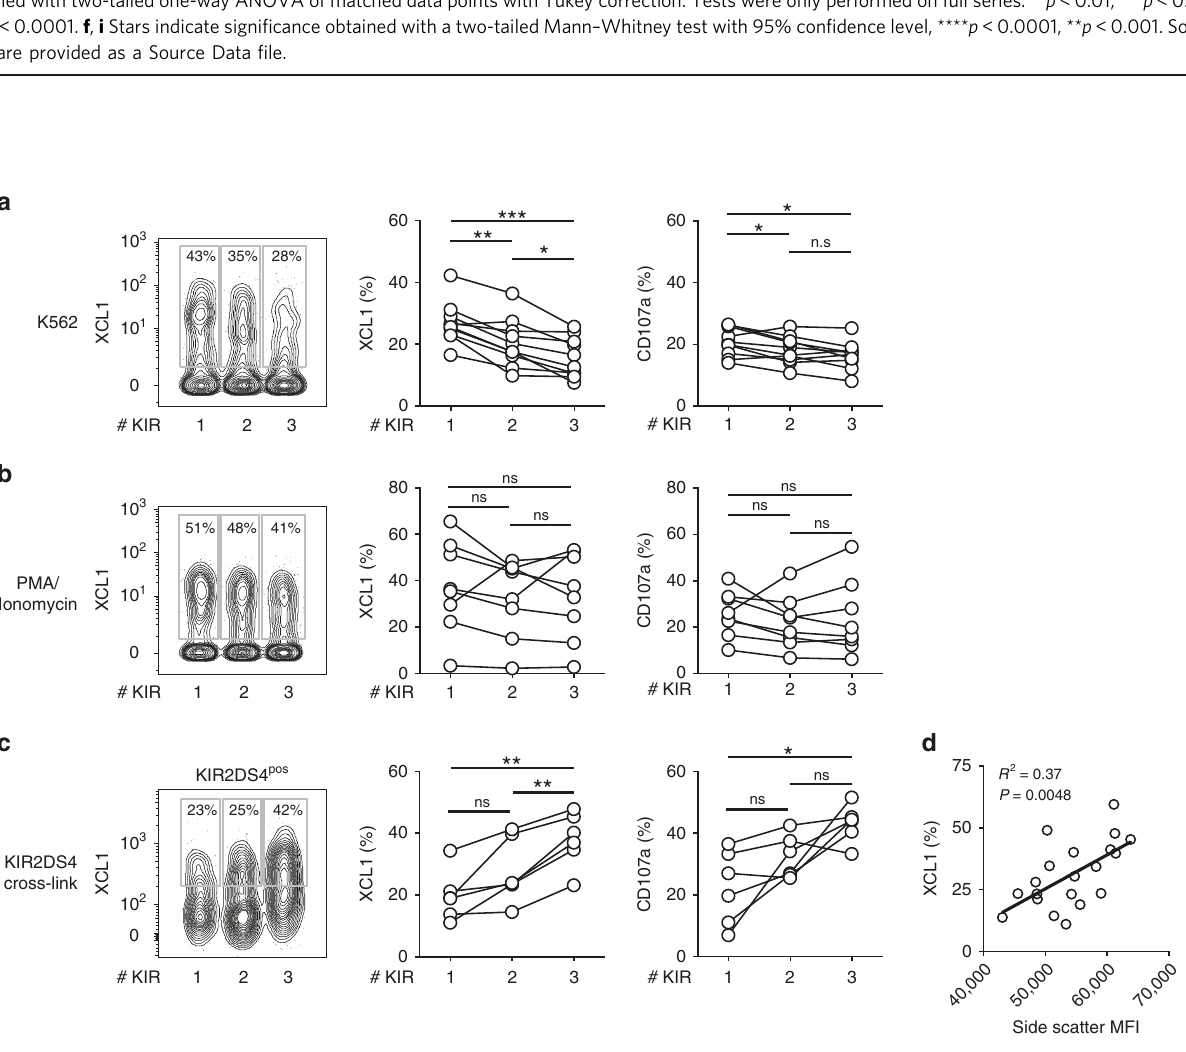
Fig. 5 dNK granule content and organisation. a Granule content represented as geometric mean fl uorescent intensity (gMFI) of side scatter in Lineage negative (Lin − ) CD56 + cell subsets co-expressing 0 – 3 Killer-cell Immunoglobulin-like Receptors (KIRs, n = 11). Lines connect dNK subsets from the same individual. b Fold increase in side scatter over previous data-point in a . c Geometrical mean fl uorescence intensity (gMFI) of Granzyme B in KIR2DS1- KIR2DS4- Lin-CD56 + cells co-expressing 0 – 2 inhibitory KIRs ( n = 11). d Granzyme B gMFI in KIR2DL1-KIR2DL2/S2/3 − Lin-CD56 + cells co-expressing